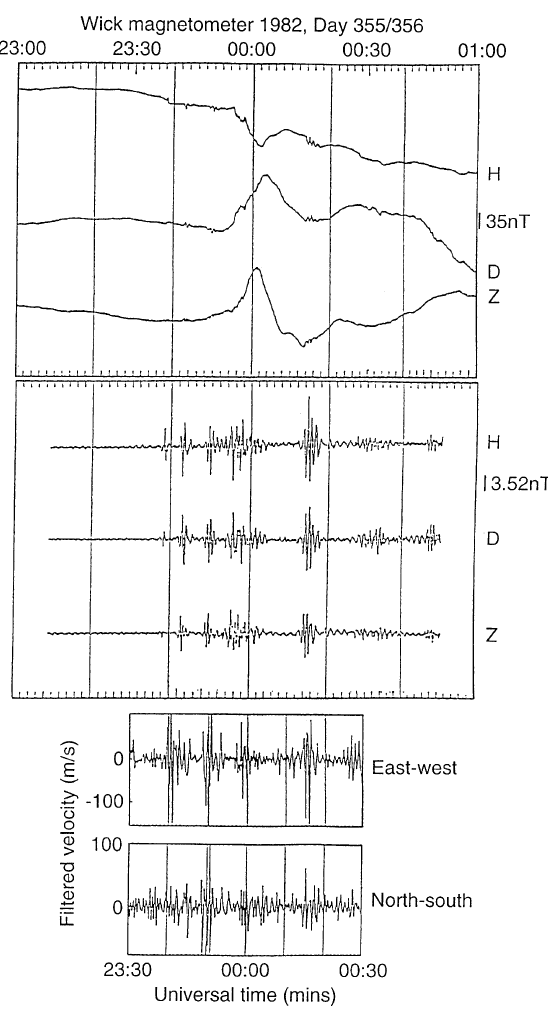
Fig. 4. Time series data for the event on day 355/356 1982. From top to bottom of the figure, unfiltered and filtered ground magnetometer data from the only operational BGS station at this time (Wick) are presented together with filtered SABRE east-west and north-south velocity component data